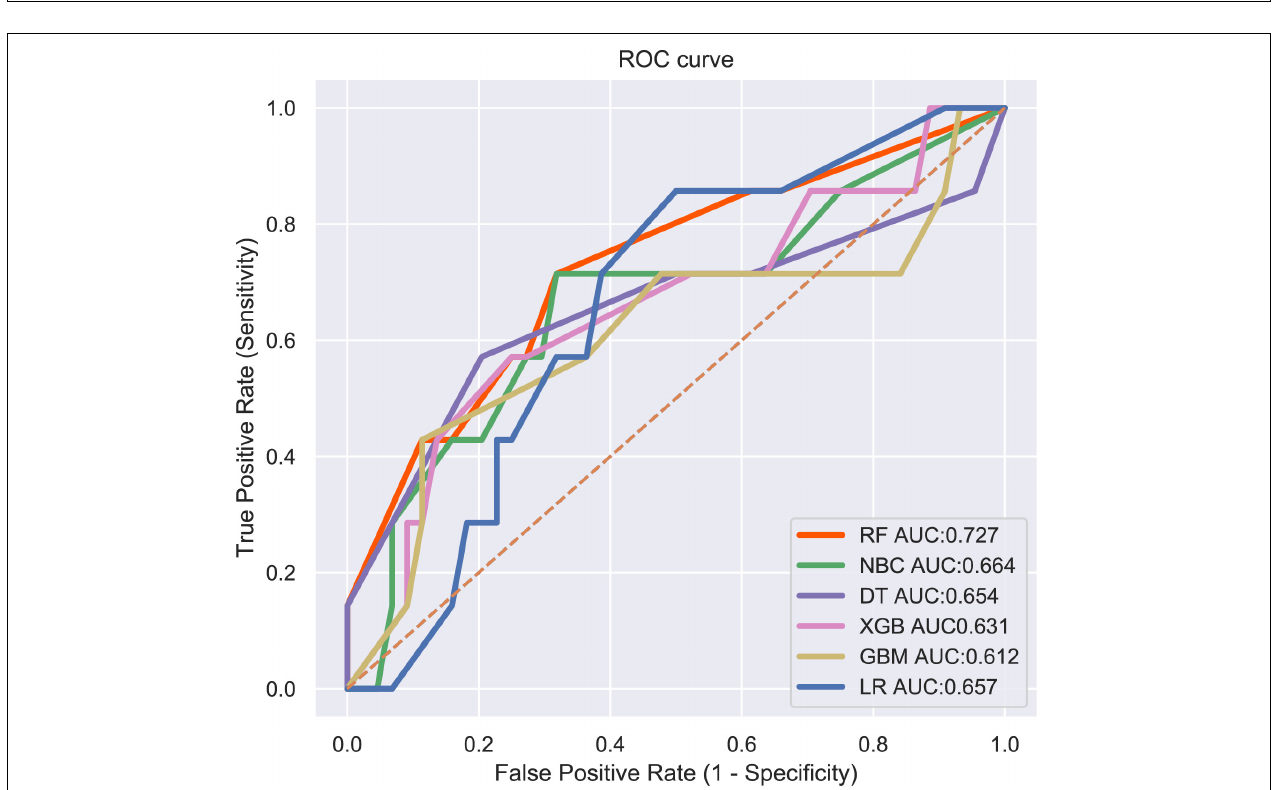
FIGURE 2 | ROC curve analysis of 6 ML algorithms for predicting LNM in patients with ES in the validation set.